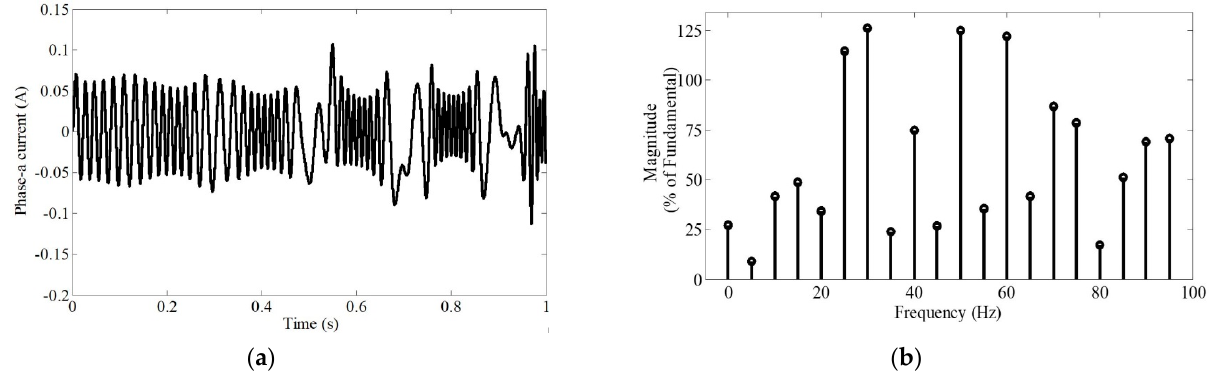
Figure 3. Analysis of rotor bar crack fault of a 5.5 kW SCIM (1 faulty bar) in non-stationary regime: ( a ) Phase-a current (i a ) with variable frequency, and ( b ) FFT spectrum of non-stationary i a .